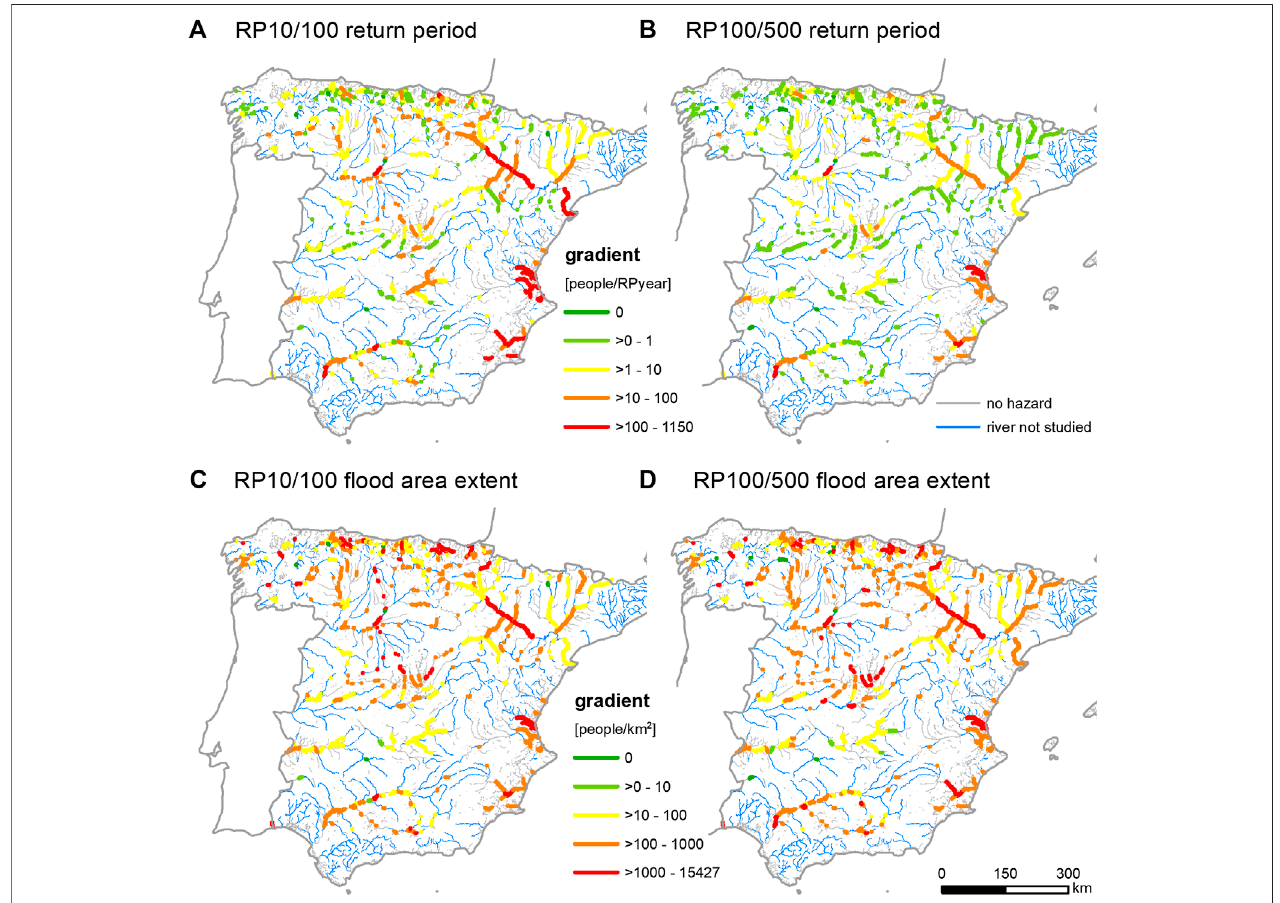
FIGURE 5 | Sensitivity of population exposure to changes in fl ood magnitude in the main river fl oodplains of Spain: (A) Gradient between an increase in exposed population and an increase in frequency (return period in years) from downward counterfactual analysis of a 1-in-10 years design fl ood. (B) Gradient derived from downward counterfactual analysis of a 1-in-100 years design fl ood. (C) Gradient between the increase in the exposed population and the increase in fl ood extent (km 2 ) from downward counterfactual analysis of a 1-in-10 years design fl ood. (D) Gradient derived from downward counterfactual analysis of a 1-in-100 years design fl